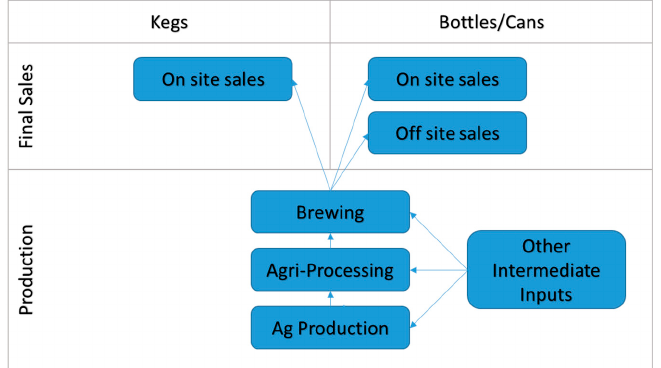
Figure 1. Michigan beer value chain.